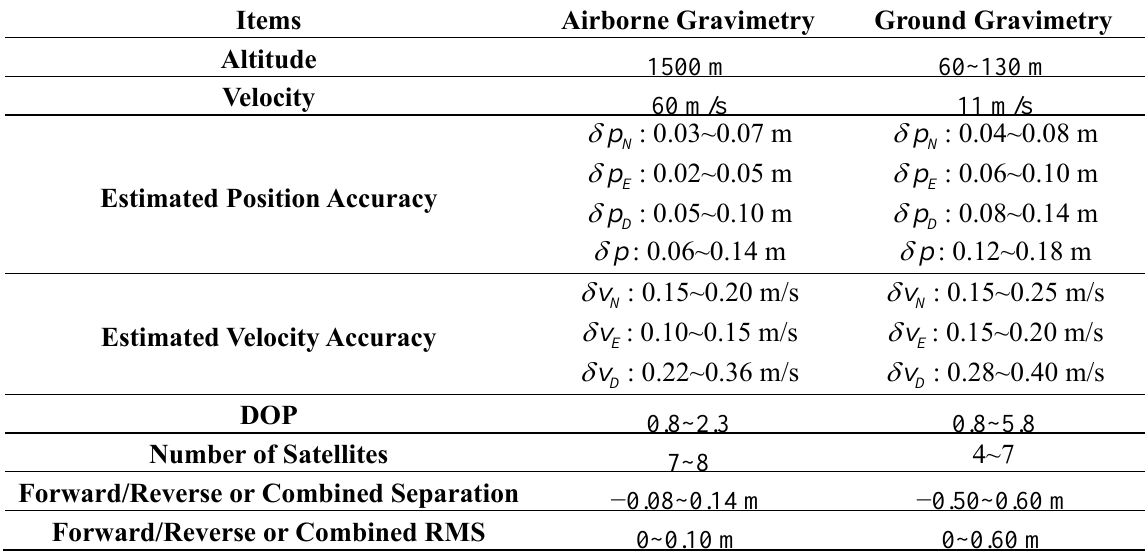
Table 1. GNSS results comparison of airborne test and ground